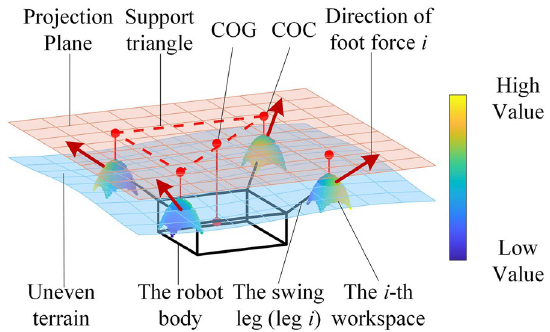
Figure 8 Magnitudes employed to characterize foot force distribution of quadruped robot by using Inverted Modelling